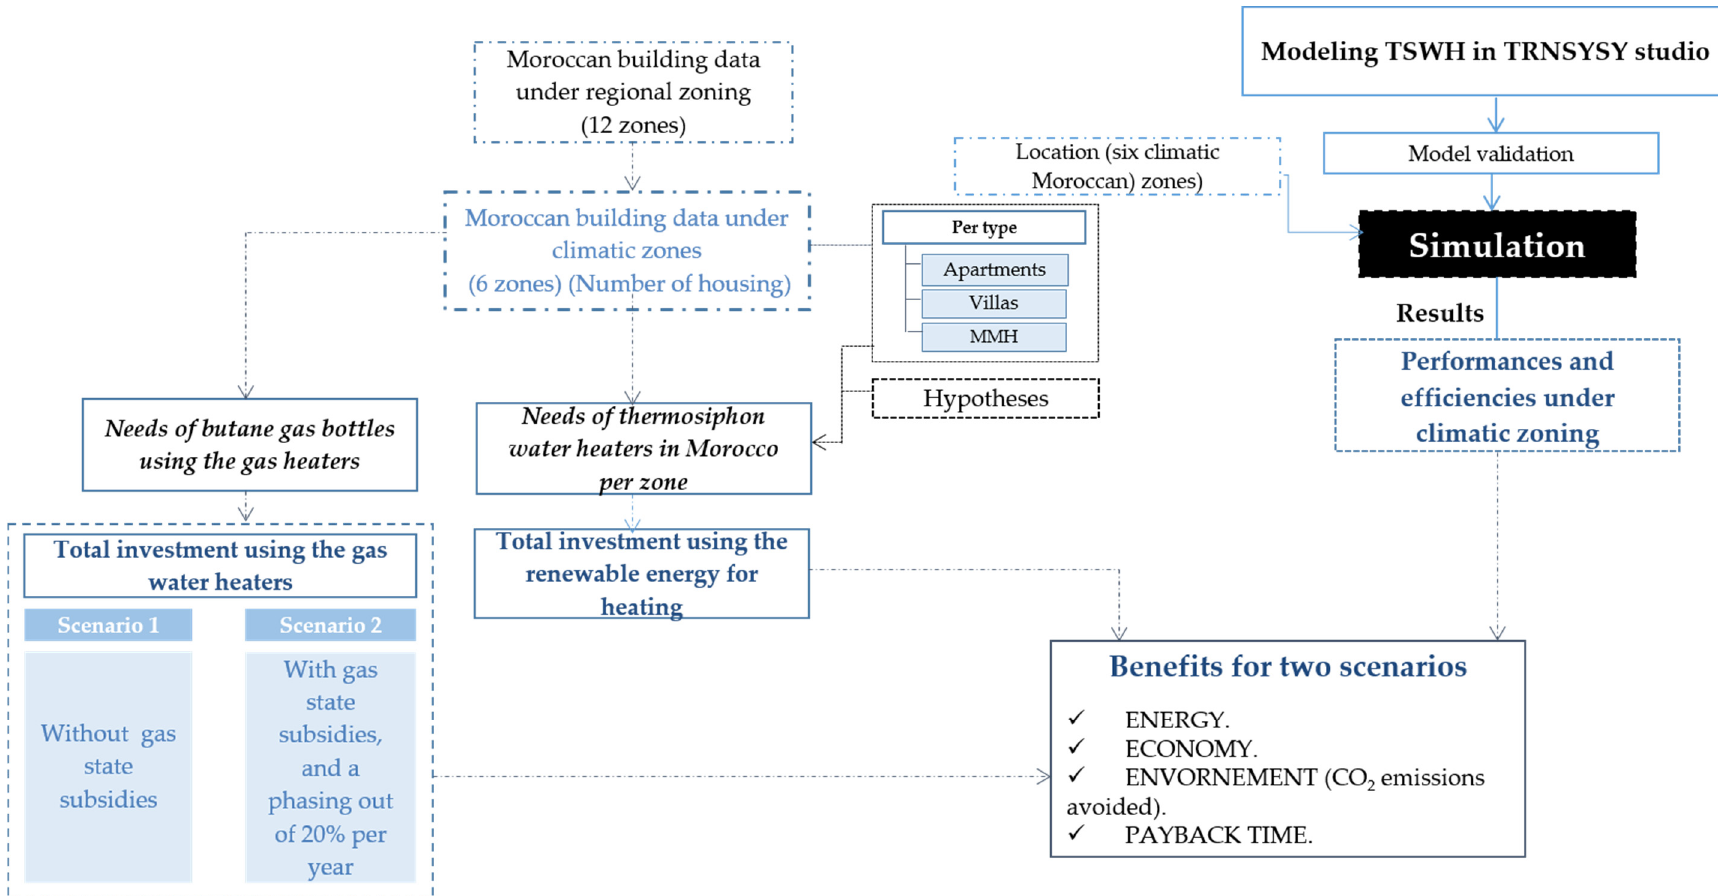
Figure 7. Methodology. Figure 7.